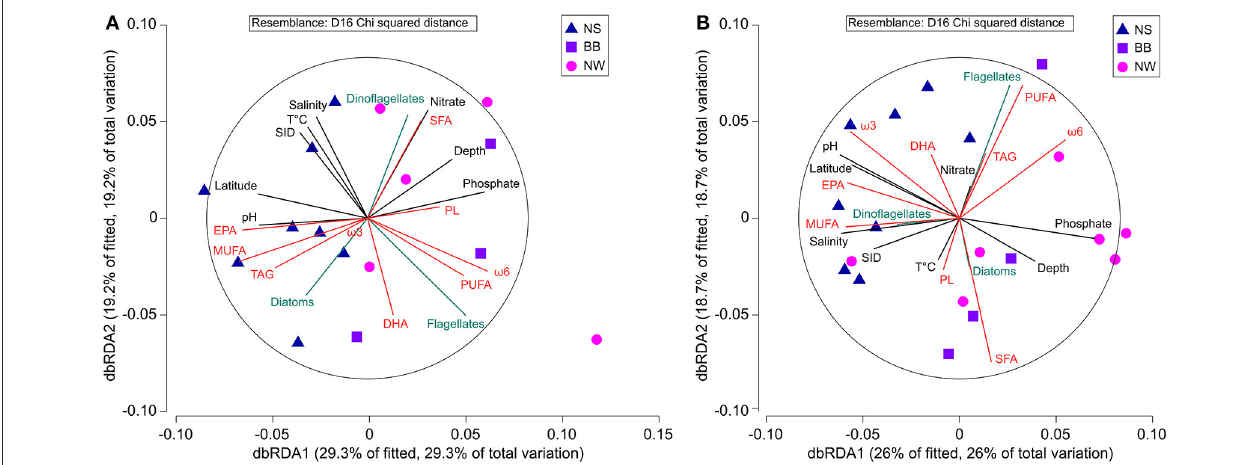
FIGURE 7 | Distance based Redundancy Analysis of lipid composition (red arrows), phytoplankton taxonomy (in term of carbon, blue arrows) and abiotic variables (black arrows) at (A) the subsurface chlorophyll maximum and (B) the surface. The blue triangles represent data from Nares Strait (NS), the purple squares represents Baffin Bay (BB) and pink circles represent the Northwest Passage